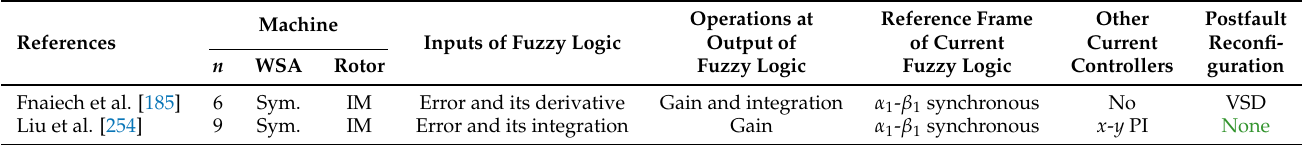
Methods based on RFOC with current fuzzy-logic control for tolerating phase OCs (Section 3.4.5) in multiphase applications in the